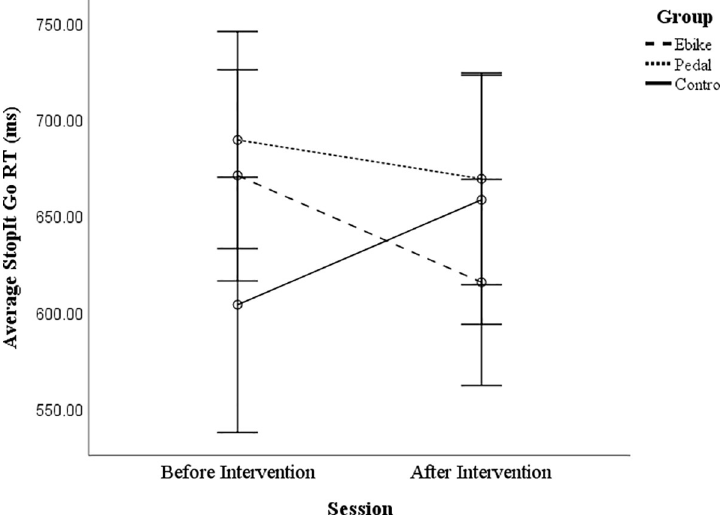
Fig 2. Stop-It task RTs (ms) for go trials for the non-cycling controls, E-bike cyclists and pedal cyclists before and after the intervention. Error bars are +/- 2 SEs.